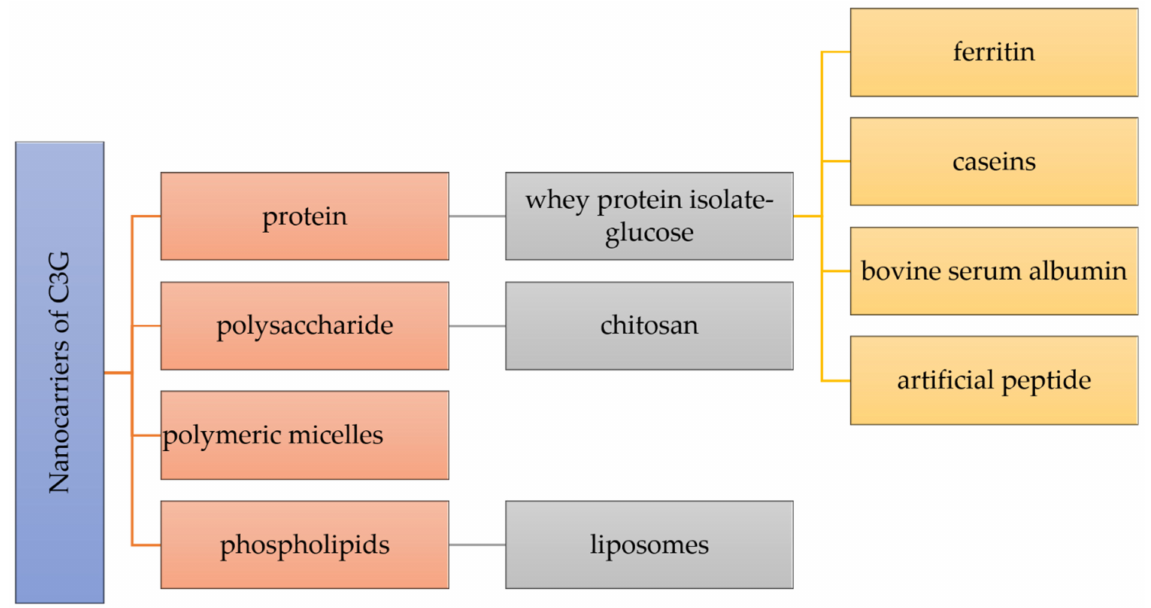
Figure 2. Different nanocarriers used for the encapsulation of cyanidin 3- O